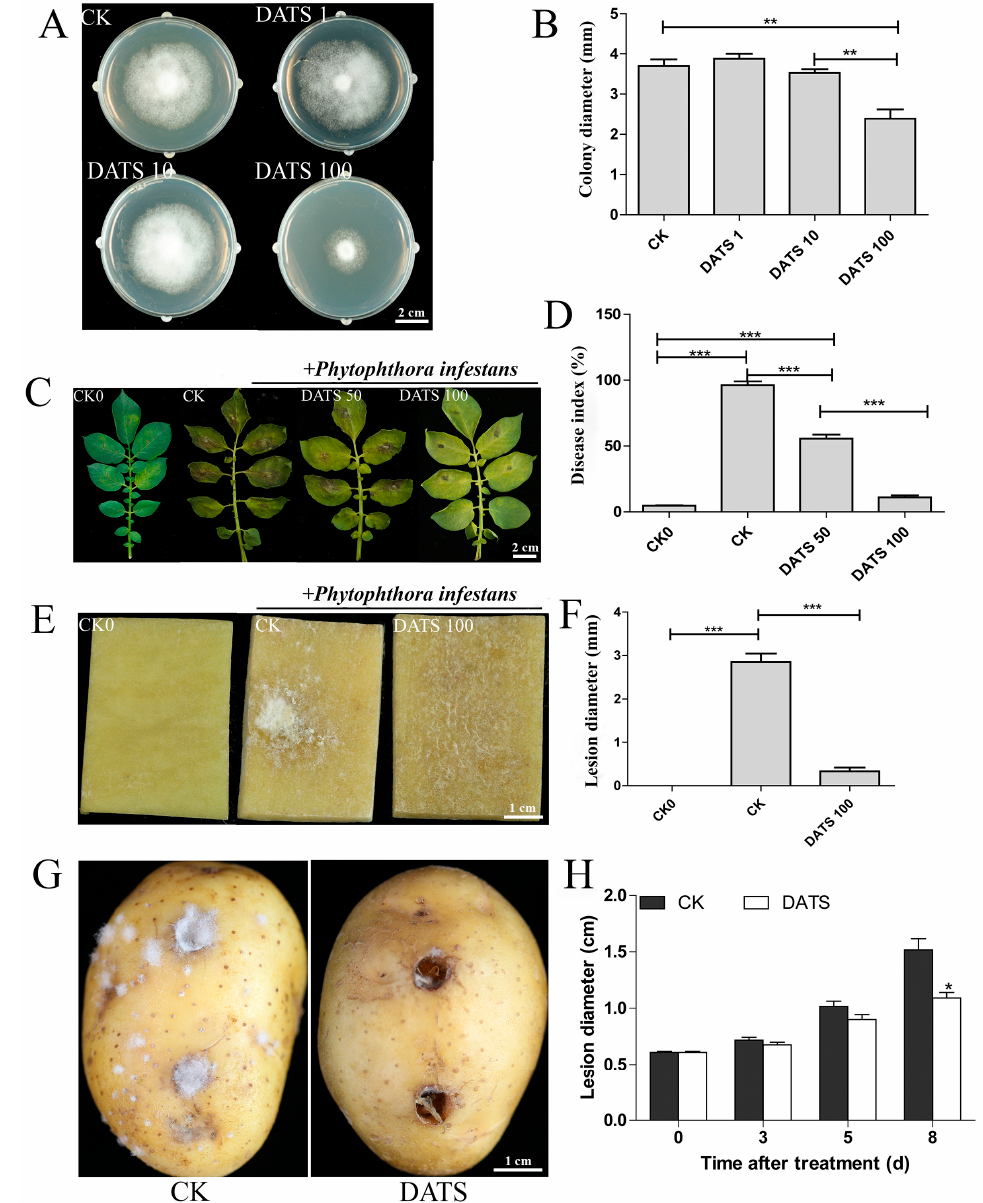
Figure 1. Effect of DATS on P. infestans and potato. ( A ) Effect of DATS on the growth of P. infestans mycelium. ( B ) The colony diameter of P. infestans treated by DATS. ( C ) Effect of DATS on P. infestans on the potato leaves. ( D ) Disease index of potato leaves infected by P. infestans with DATS. ( E ) Effect of DATS on P. infestans on the potato cubes. ( F ) Lesion diameter of potato cubes infected by P. infestans with DATS. ( G ) The potato tubers pretreated by DATS (100 µ g L − 1 ) infected by P. infestans . ( H ) Lesion diameter of the potato tubers pretreated by DATS infected by P. infestans . LSD was calculated to compare significant differences between DATS treatment and CK treatment, * p < 0.05, ** p < 0.01, *** p < 0.001, unmarked = not significant, n ≥ 3. Data are shown as means ± standard deviation (SD). CK0 indicates neither P. infestans infection nor treatment with DATS; CK indicates the detached leaf or potato tuber is not treated with DATS; DATS1, 10, 50, 100 indicate the concentration of DATS (1, 10, 50, 100 μ g L − 1 ); DATS: diallyl trisulfide.